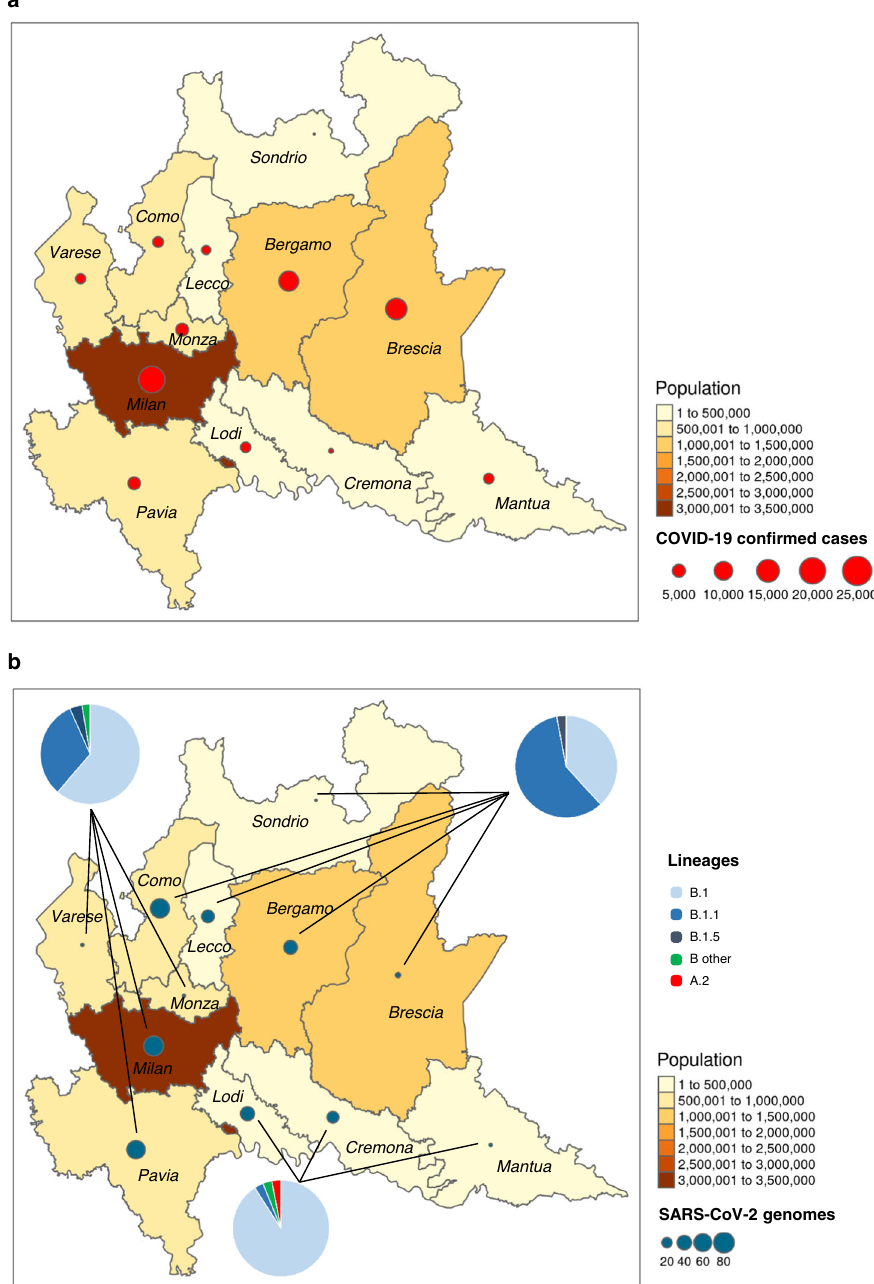
Fig. 1 Distribution of SARS-CoV-2 in Lombardy. a Geographic distribution of COVID-19 con fi rmed cases and population density among the 12 provinces of Lombardy. b Geographic distribution of SARS-CoV-2 genomes, the lineages detected, and population density among the 12 provinces of Lombardy. Maps were obtained, thanks to the free available software Rgui using the R statistic library